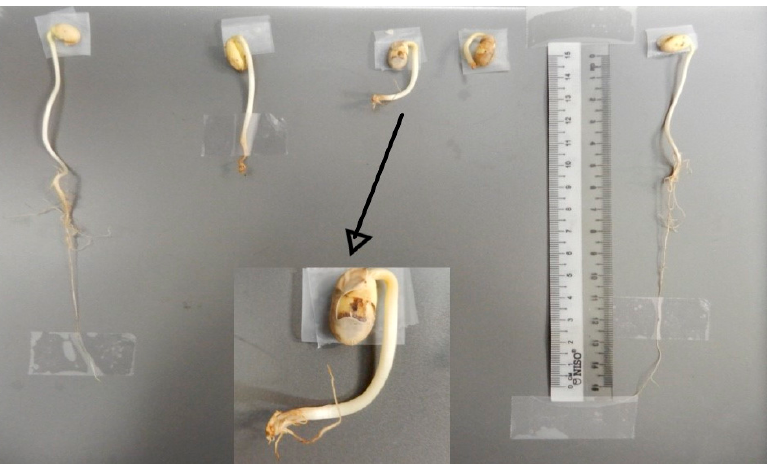
Figure 7. Normal (extremes) and abnormal (center) seedling samples produced by cultivar C01 in the control group.